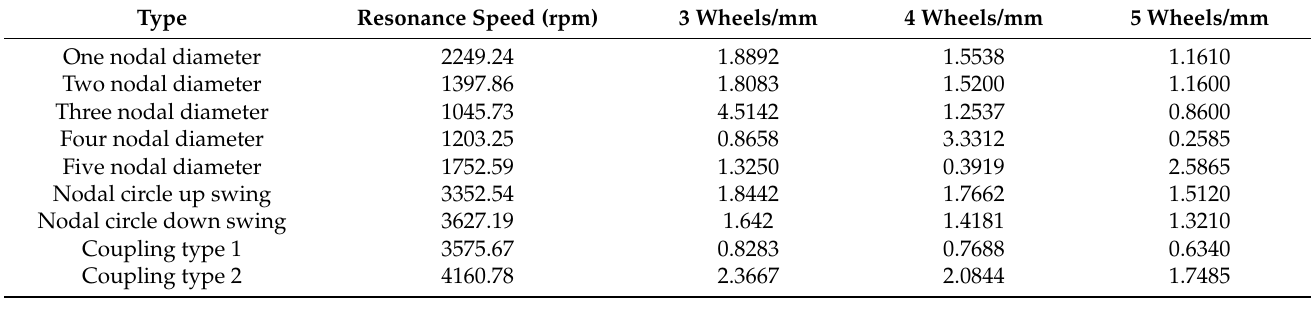
Table 5. Comparison of vibration displacement response fluctuation amplitude.